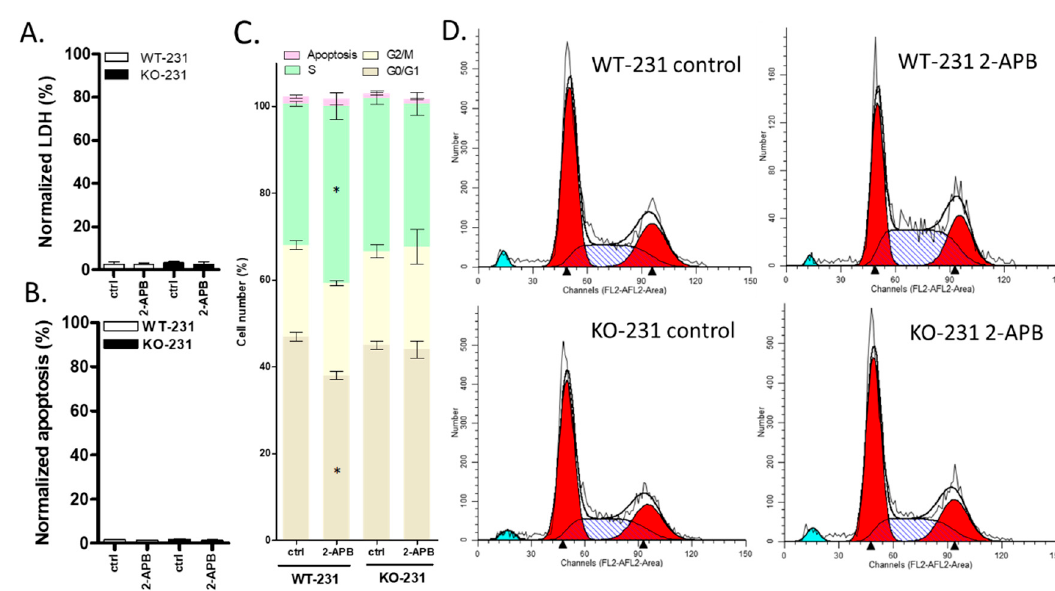
Figure 7. The effect of 2-APB on TRPM7 knockout MDA-MB-231 cell biology. ( A – D ) show data for cells exposed to 100 µM 2-APB for 24 h. ( A ) LDH release. 2-APB had no significant effect on LDH. ( B )